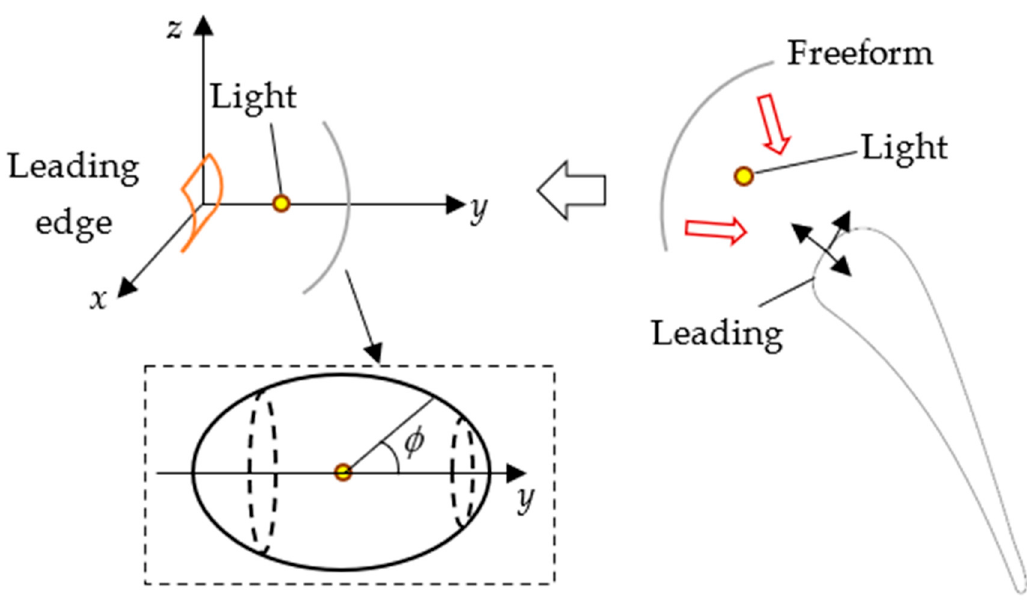
Figure 1. The sketch of the radiation heating system for the leading edge of a turbine vane.